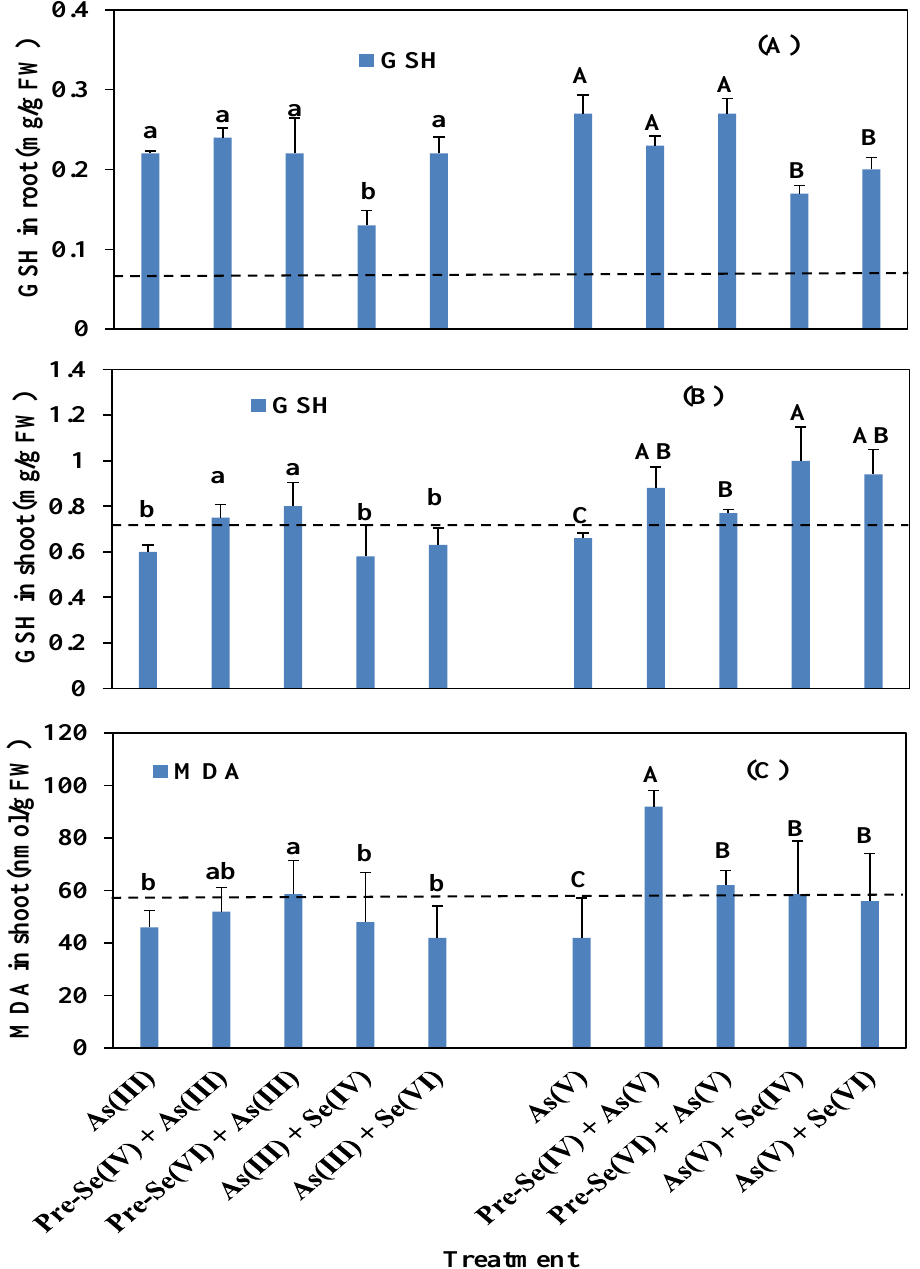
Figure 6. Effect of Se pretreatments and co-application on antioxidative non-enzyme levels in rice roots ( A ) and shoots ( B , C ) treated with 5 µM (As and Se). Data represent mean value ± SE (n = 3). Discontinuous lines indicate reference lines relative to the control. The letters represent statistically significant ( p < 0.05) differences among treatments.